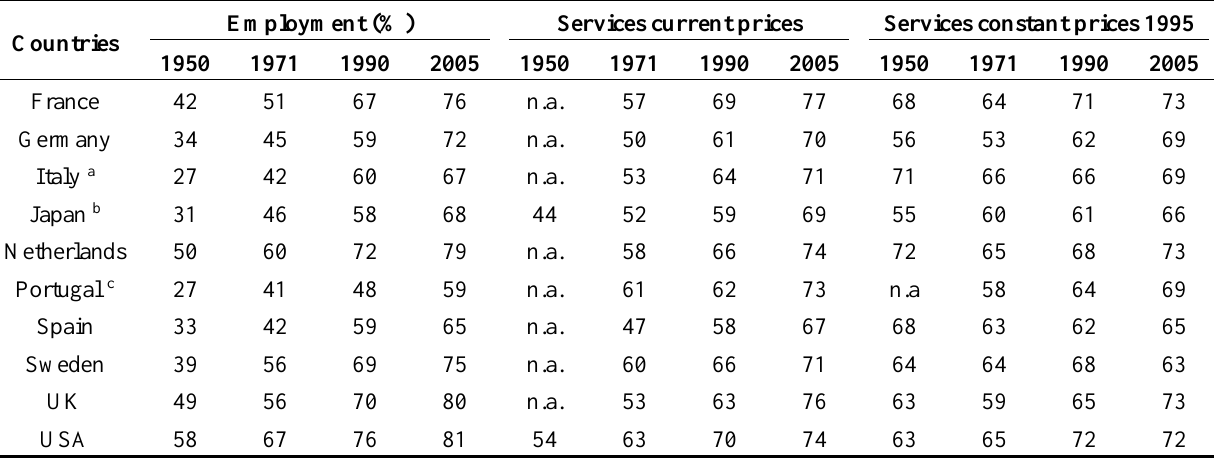
Table 1. Service sector share (of GDP in current and constant prices, in employment), 1950, 1971, 1990 and 2005.